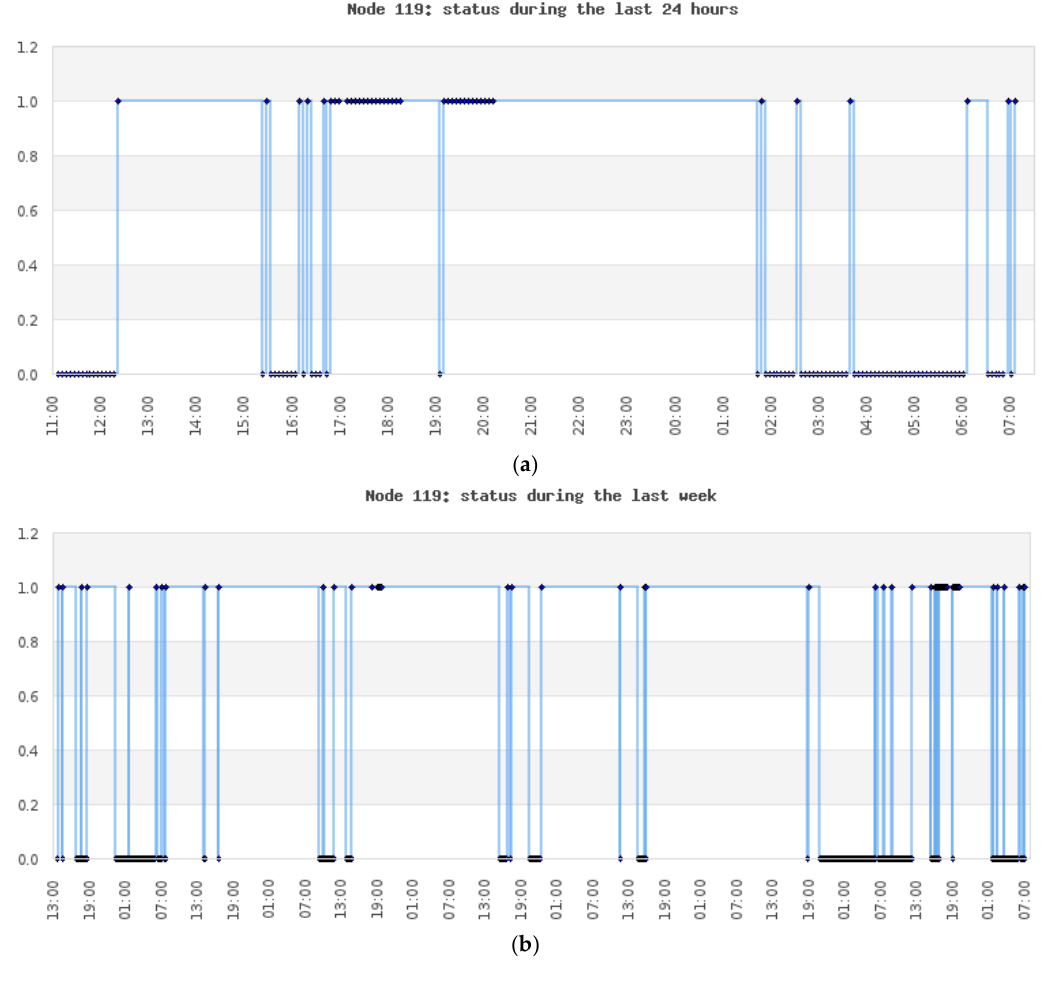
Figure 6. Example of ( a ) daily and ( b ) weekly city parking lot management reports after internet of things (IoT) implementation.